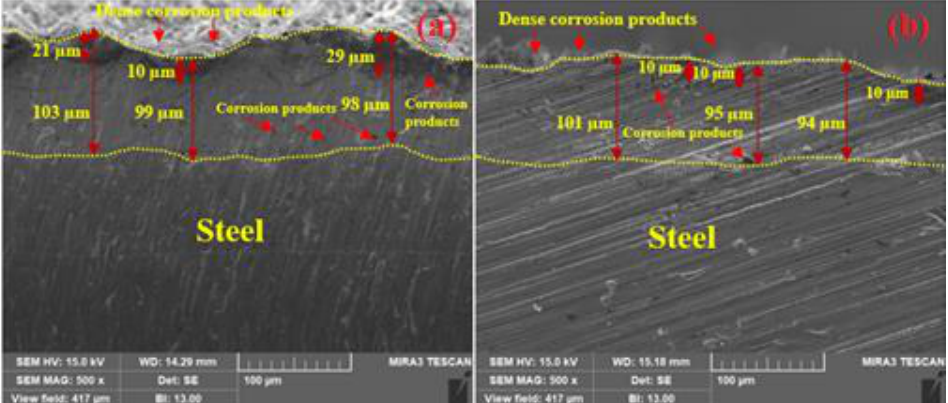
Figure 13. SEM images of cross-sectional views of corrosion products formed on the zinc coatings deposited by the ( a ) arc thermal spray and ( b ) plasma arc thermal spray processes at 500× after 23 d of exposure to artificial seawater. Table 6. EDS analysis of corrosion products.